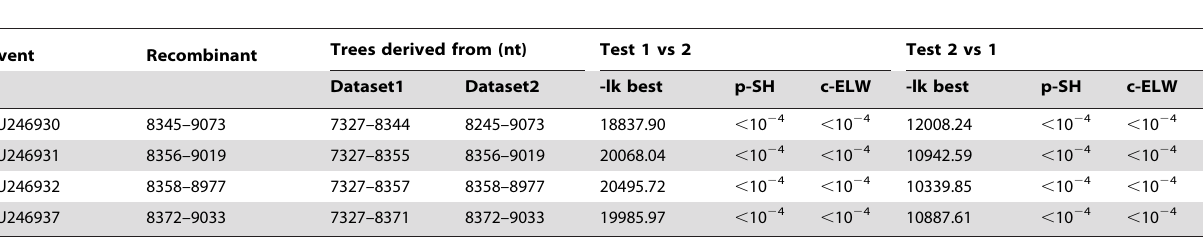
Table 5. Statistical tests for alternative topologies derived from the recombination events